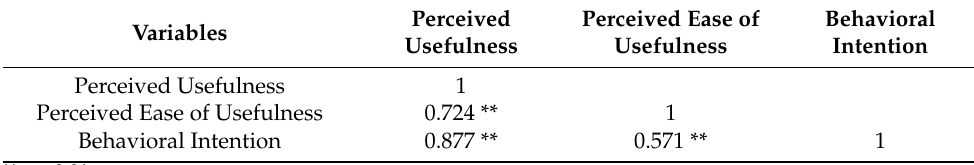
Table 4. Correlation matrix of PU, PEU, and BI.